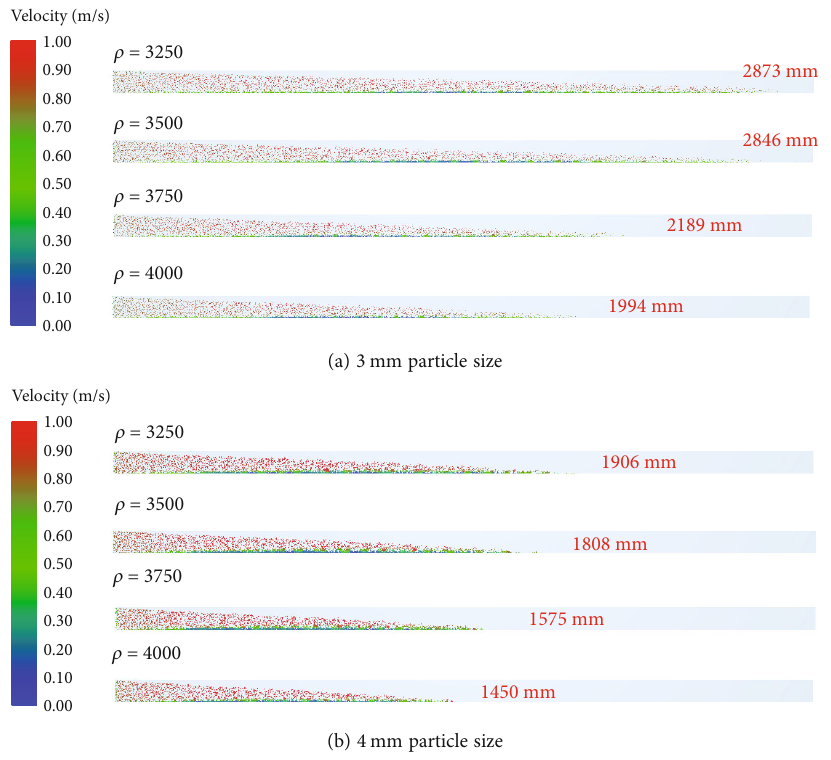
Figure 5: Velocity cloud map of aggregate at 3mm and 4mm particle size